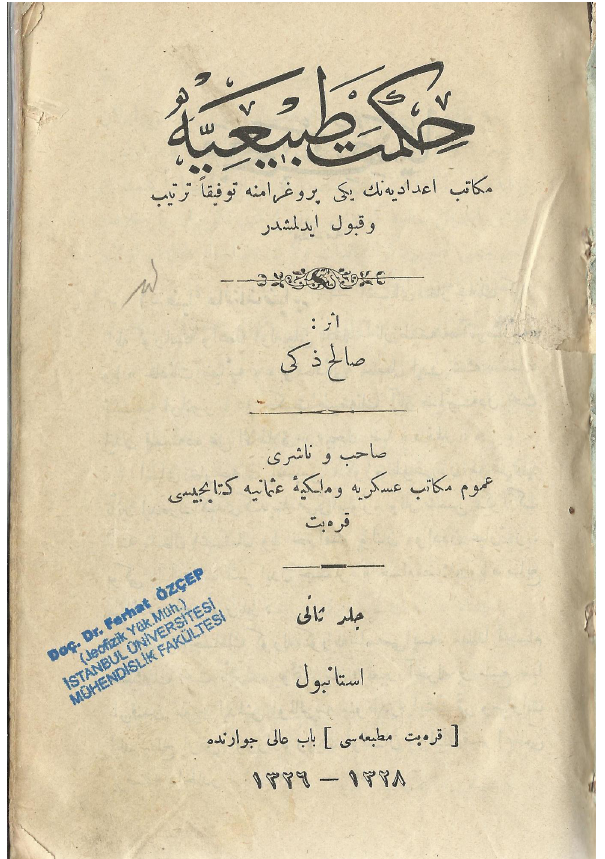
Figure 3e. Cover page of Asar-Bakiye (Immortal Works) written by Salih Zeki in 1900 (from my own